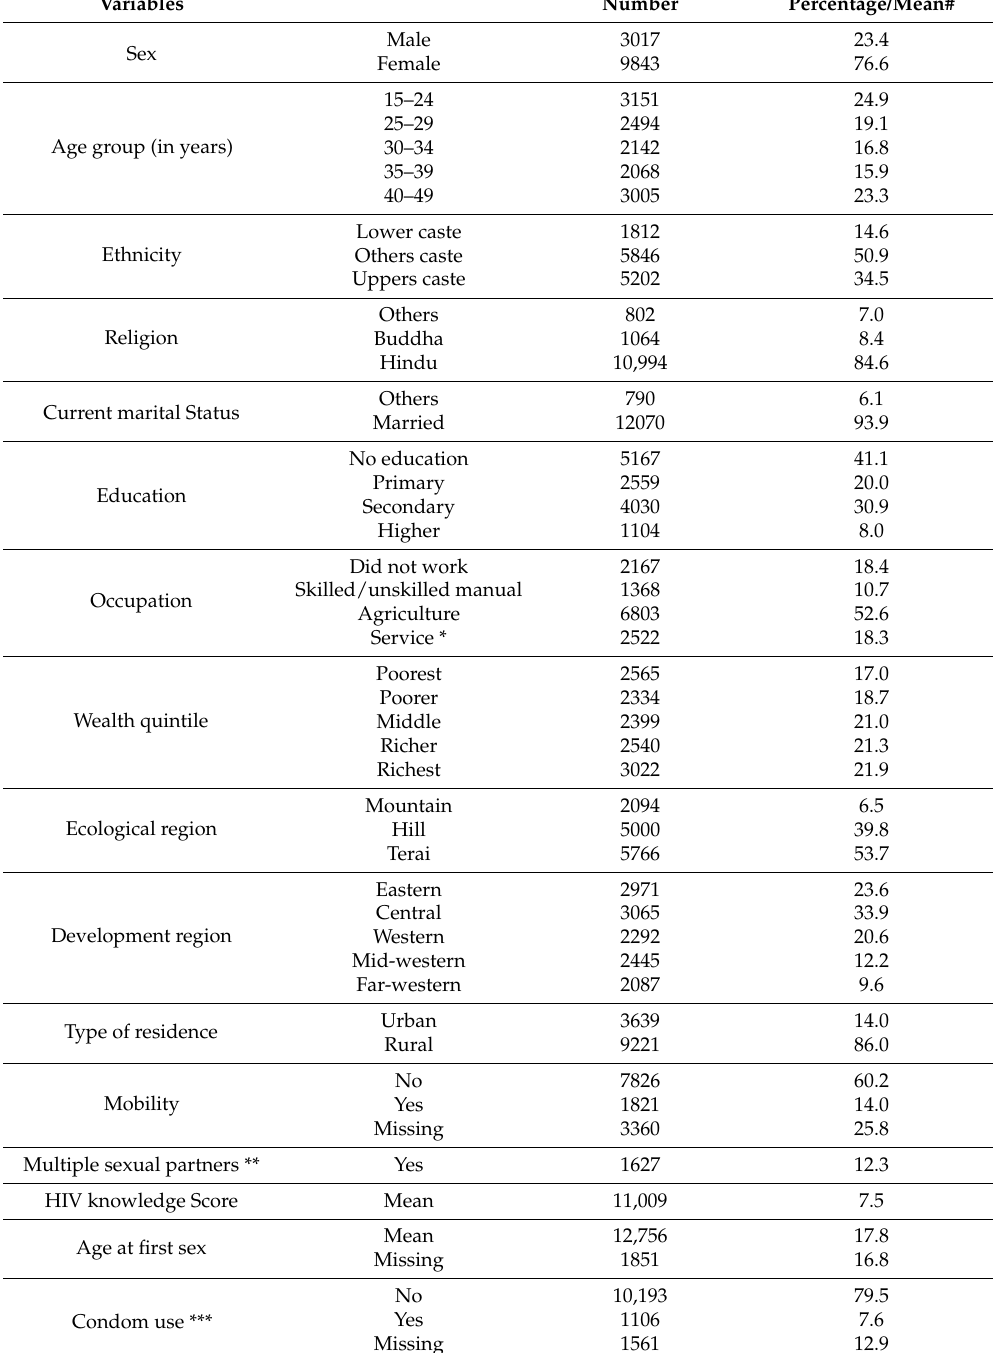
Table 1. Sociodemographic Characteristics of the Study Population ( N =